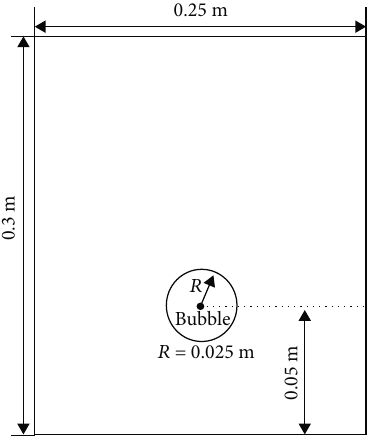
Figure 8: Computational domain and initial bubble location in the simulation of bubble